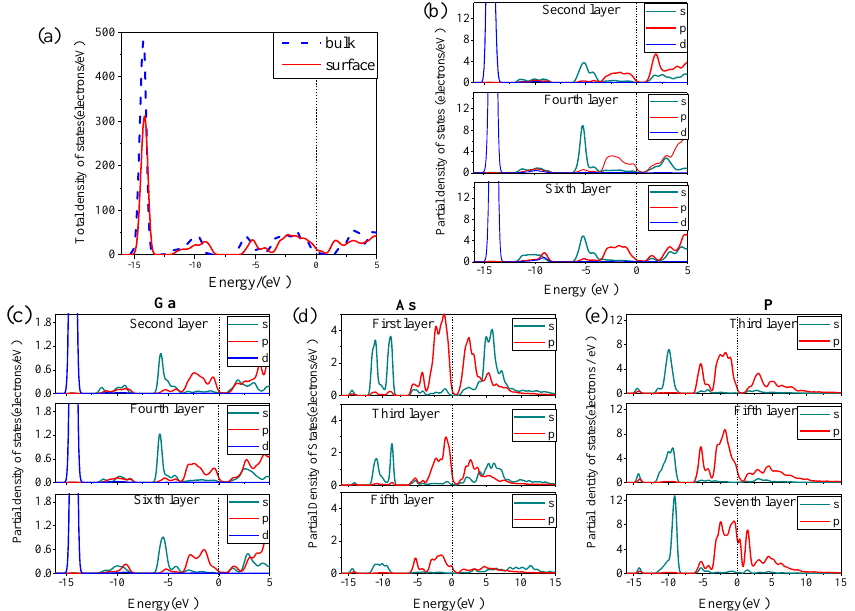
Figure 4. ( a ) Total DOS of the In 0.87 Ga 0.13 As 0.25 P 0.75 bulk and surface, ( b – e ) the partial DOS of the In, Ga, As and P atom in every layer.